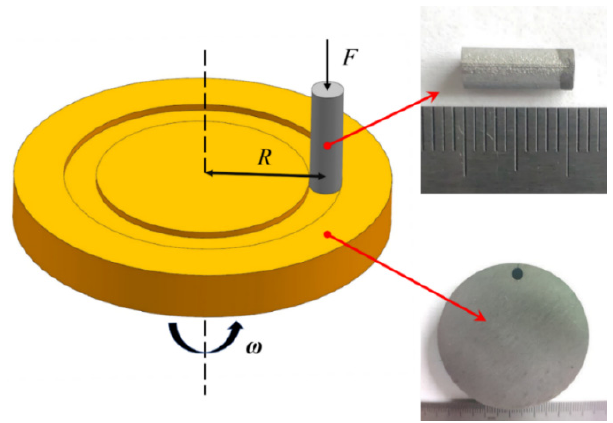
Figure 2. the schematic of the wear test. Where R is the wear track radius, F is the normal force on the pin, and ω is the rotation velocity of the disk.